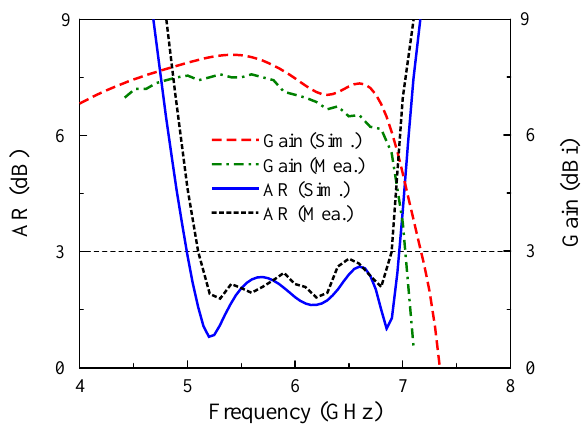
Figure 9. Simulated and measured |S 11 | of the proposed antenna.